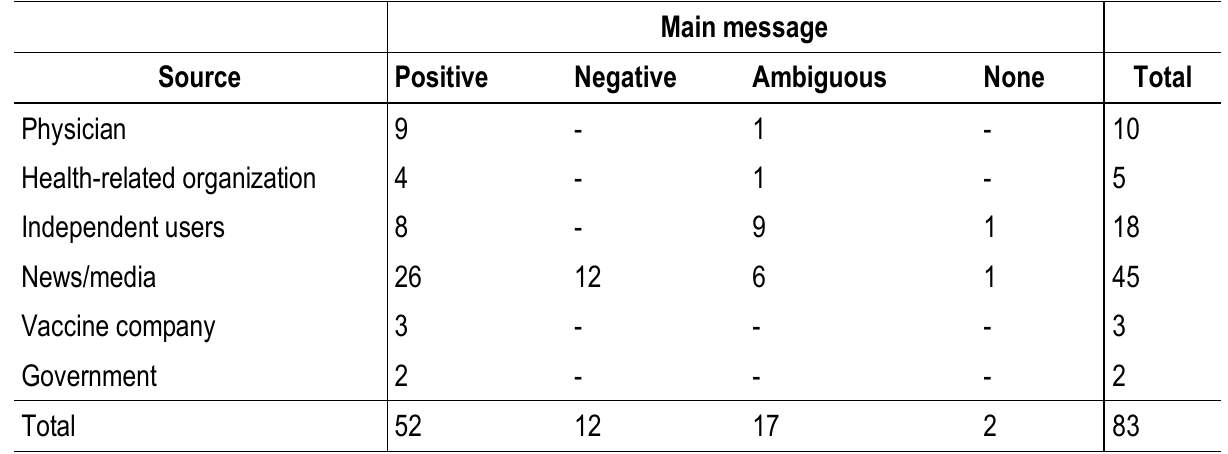
Table 2. Main message categorization of the videos according to sources, (n)